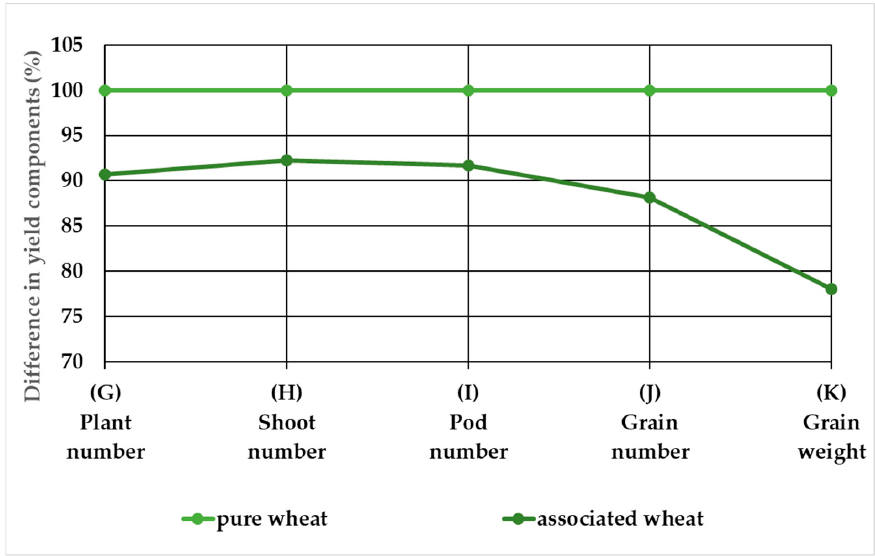
Figure 3. Development line of pure winter pea ( Pisum sativum L.) and associated winter pea ( Pisum sativum L.) over an average of 2 years.